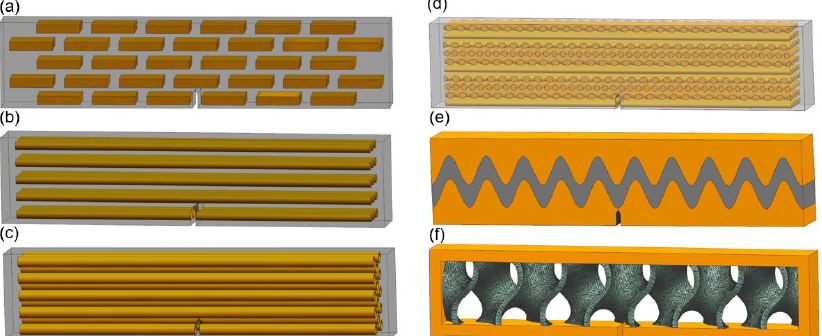
Figure 16. Sample design of the six biological models for three-point bending test. ( a ) Layered ( b ) Columnar ( c ) Tubular ( d ) Helical ( e ) Sutured ( f ) Sandwich.